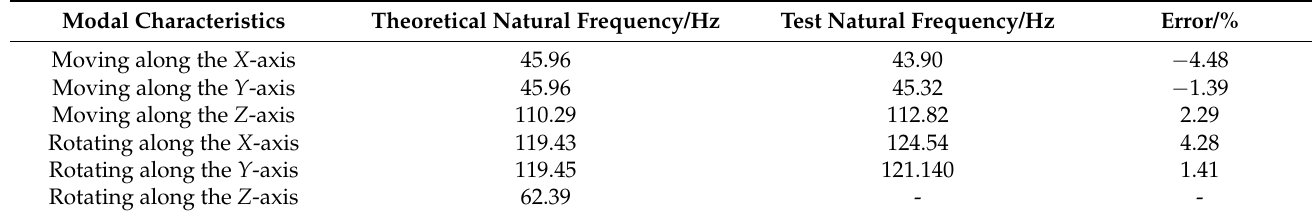
Table 4. Comparison between Stewart platform test and natural frequency.